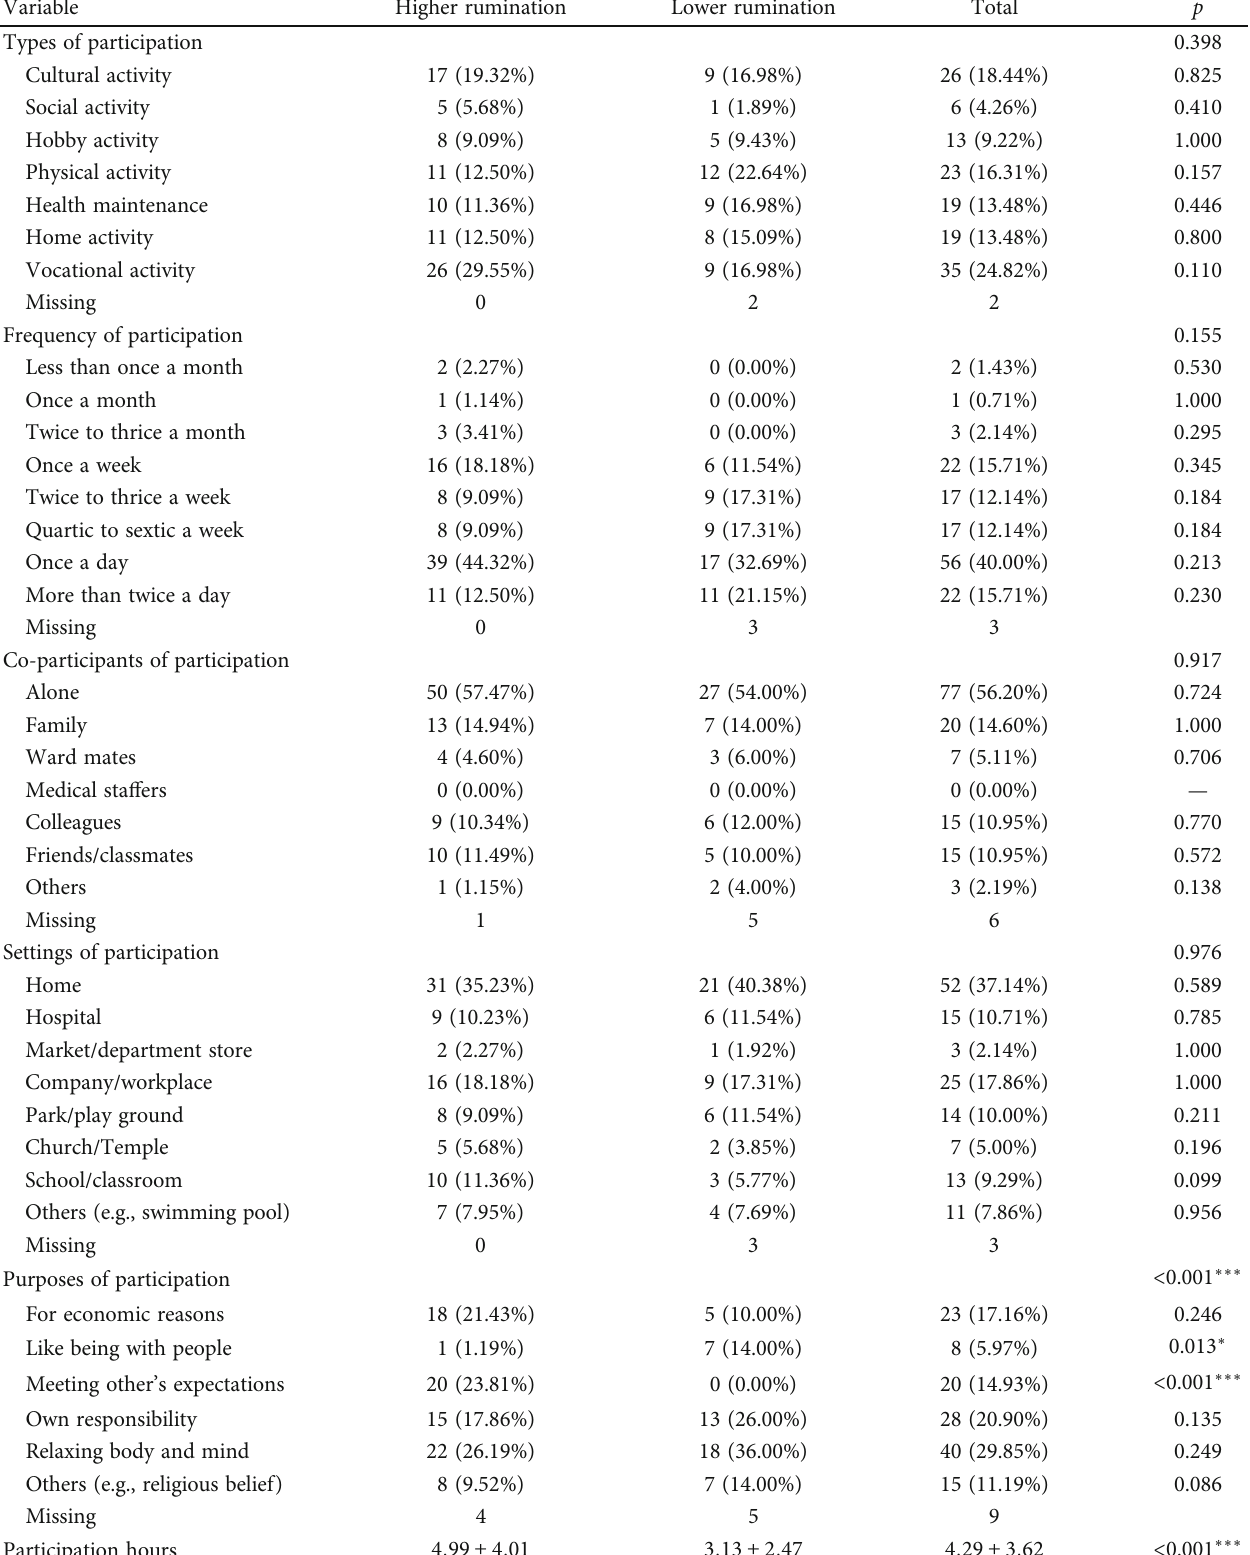
Table 2: The di ff erences in participation pro fi les of the most meaningful activities between participants with higher vs. lower rumination